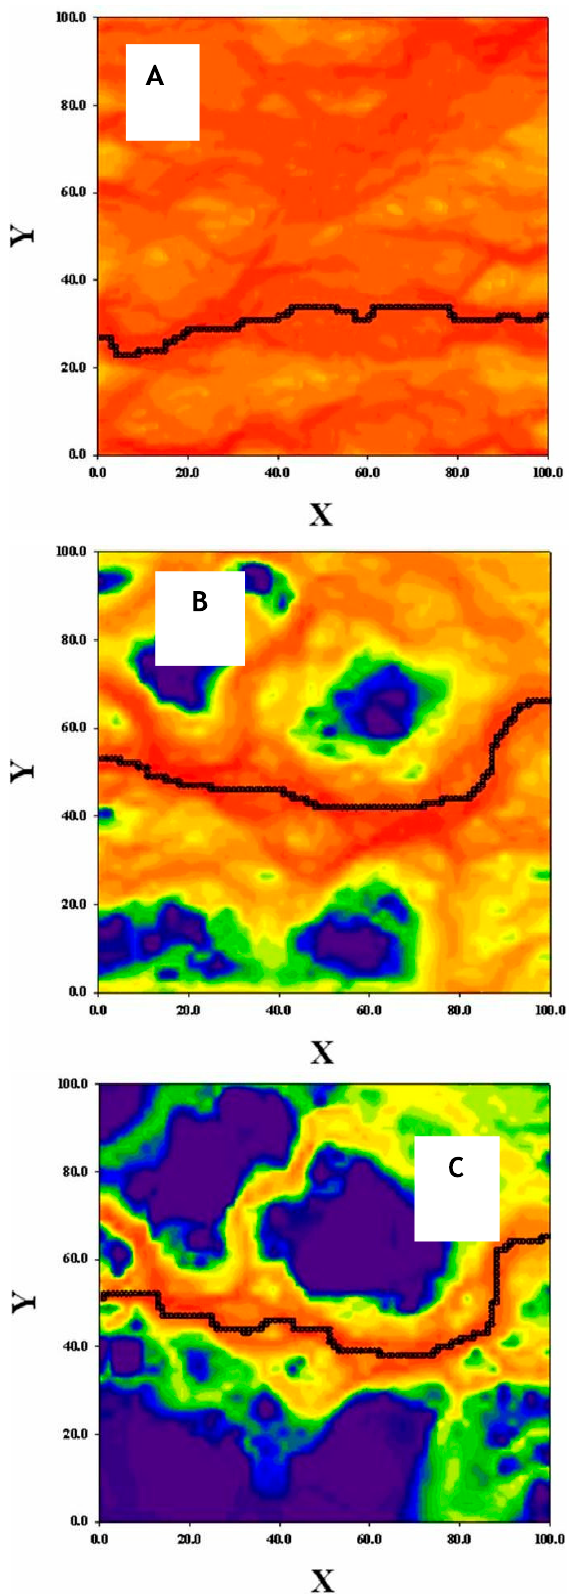
Figure 9. Trajectories of solute particles passing through a channel with relatively large localized flows when σ (cid:48) increased at λ / L = 0.3: ( A ) σ (cid:48) = 0.0 MPa, ( B ) σ (cid:48) = 15.0 MPa, and ( C ) σ (cid:48) = 35.0 MPa.